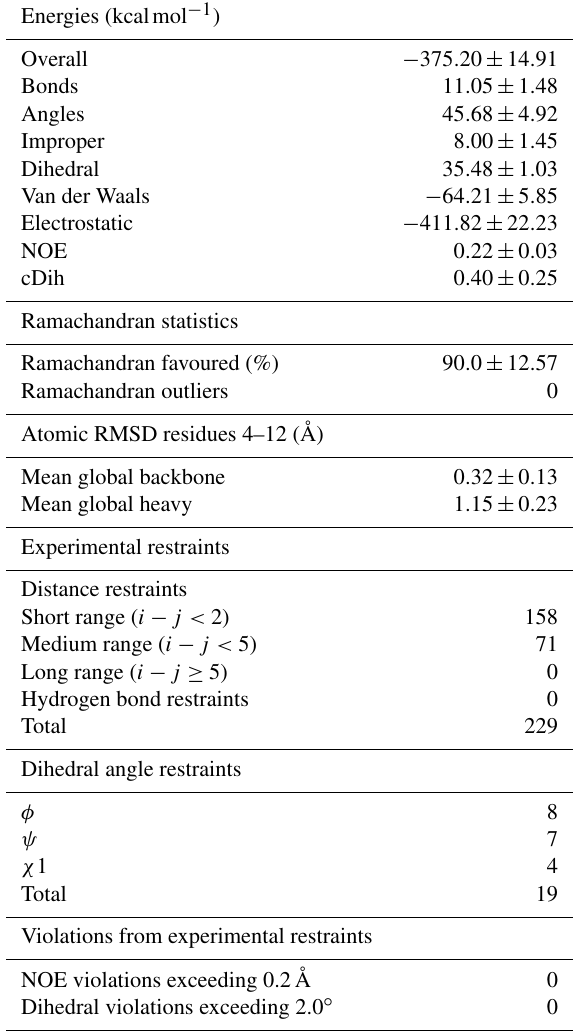
Table 1. Structural statistics from CNS calculations. (RMSD repre- sents root-mean-square